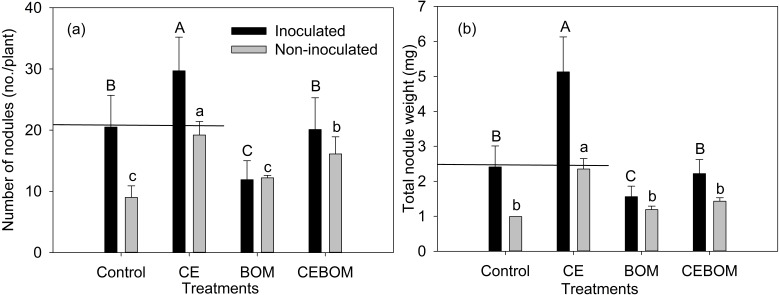
Effects of soil amendment treatments: control, compost extract (CE), bio-organic manure (BOM) and compost extract + bio-organic manure (CEBOM) on inoculated and non-inoculated nodulation of lucerne plants.(A): number of nodules; (B): total nodule weight. Straight line showed the same level between inoculated control and non-inoculated CE adding treatment. Bars represent standard errors, n = 20.